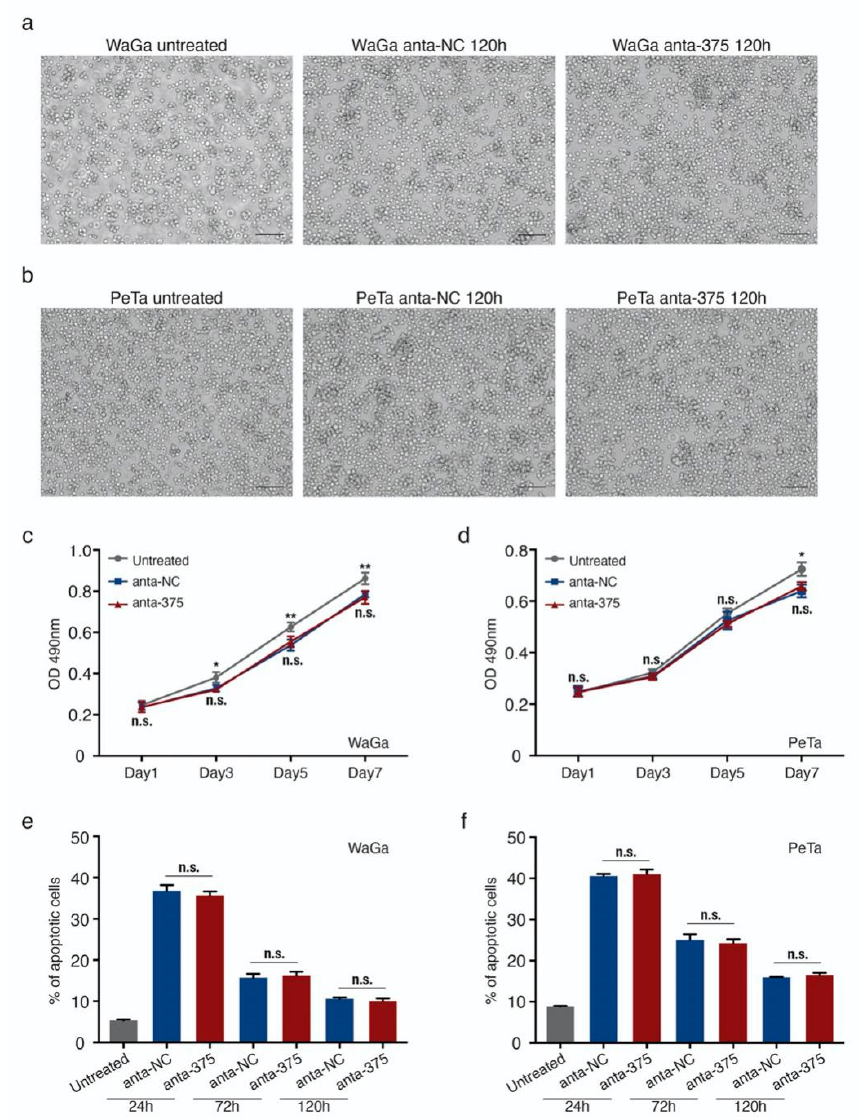
Figure 2. miR-375 knockdown does not alter the cell morphology, viability, and apoptosis of MCC cells. ( a and b ) Morphology of WaGa ( a ) and PeTa ( b ) cells, untransfected (untreated) and 120 h after nucleofection with either anta-NC or anta-375. ( c , d ) Cell proliferation (metabolic activity) of WaGa ( c ) and PeTa ( d ) cells after nucleofection with miR-375 antagomiRs or a negative control was measured by MTS assays at the indicated time points. Absorbance values at 490 nm are presented. Scale bar: 100 µ M. ( e , f ) The apoptotic cell rate of untreated or nuclear transfected WaGa ( e ) and PeTa ( f ) cells was determined by flow cytometry using the NucView 488 / MitoView 633 apoptosis assay. Scale bar represents 50 µ m. All experiments were independently repeated three times, error bars represent SD, * indicates p < 0.05, and ** indicates p < 0.01. n.s.: non-significant.